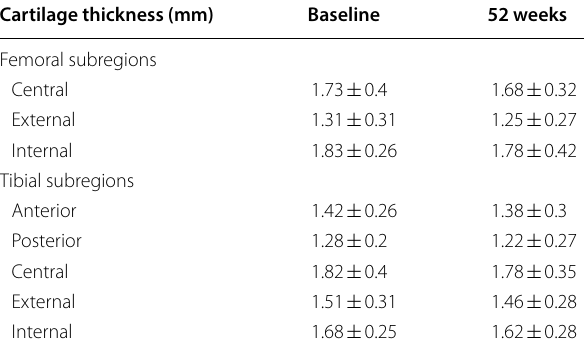
Cartilage thickness normalized to the total area of subchondral bone (mean ±